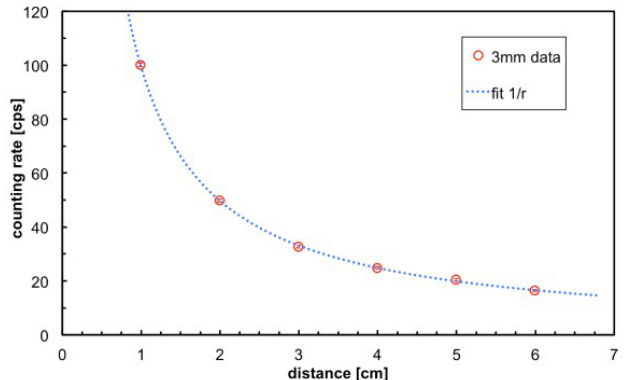
Fig. 8. Measured count rate vs distance between the point like 22 Na source and the 3 mm diameter fiber.